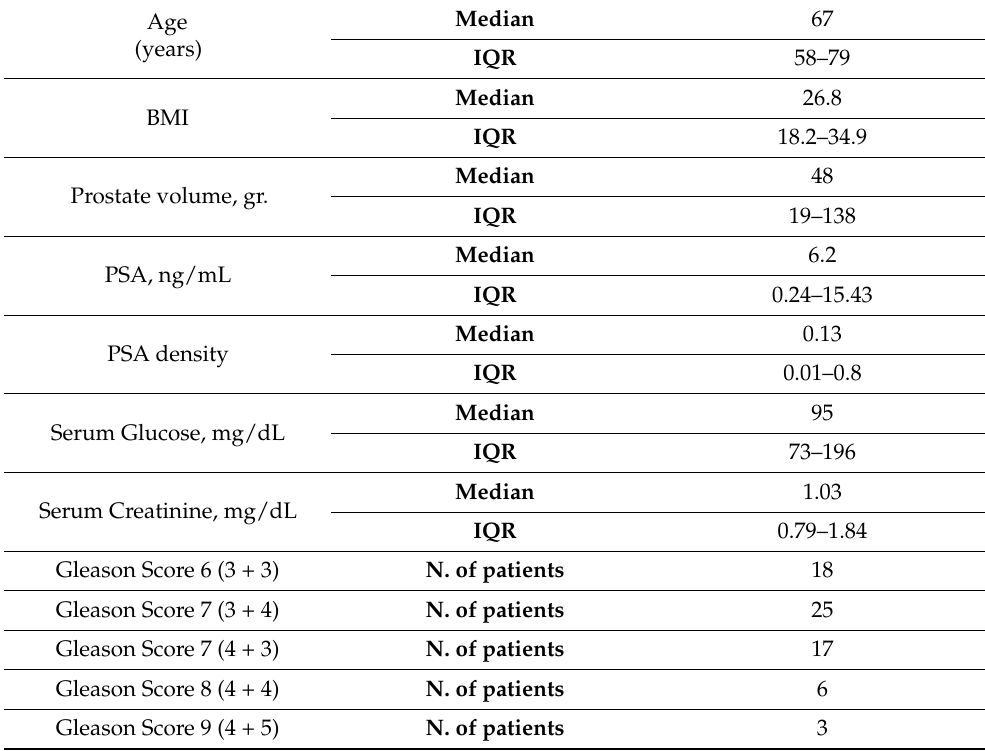
Table 1. General characteristics of the study population.